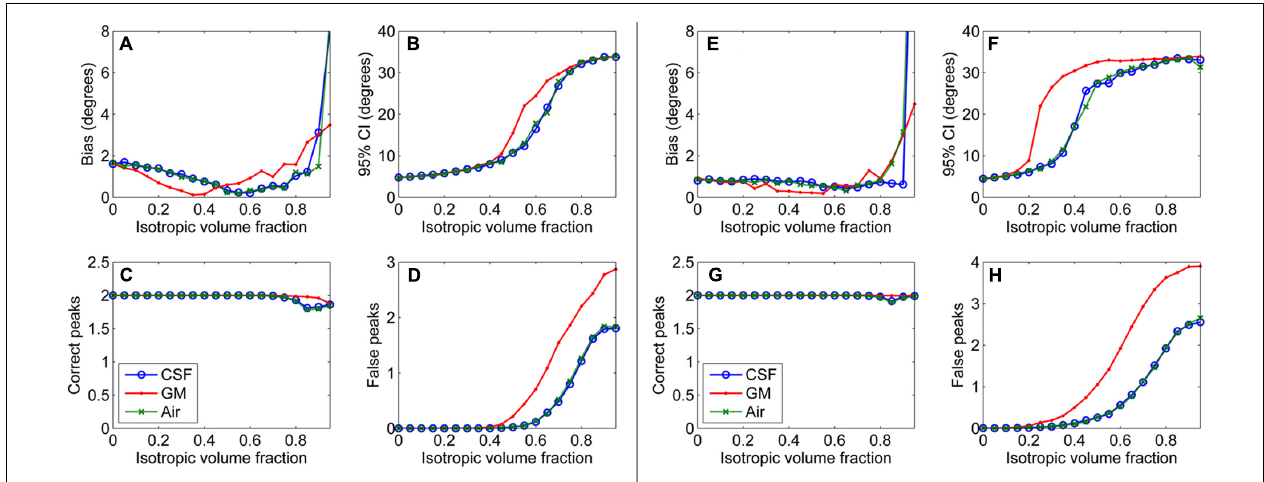
FIGURE 1 | Effect of isotropic volume fraction with CSF, GM, and air to bias, 95% confidence interval (CI), and the number of correct and false peaks estimated with CSD using up to eighth-order SH (A–D) and super-resolved CSD using up to 12th-order SH (E–H; with diffusion weighting 3000 s/mm 2 , angle 70 ◦ , and SNR 30).